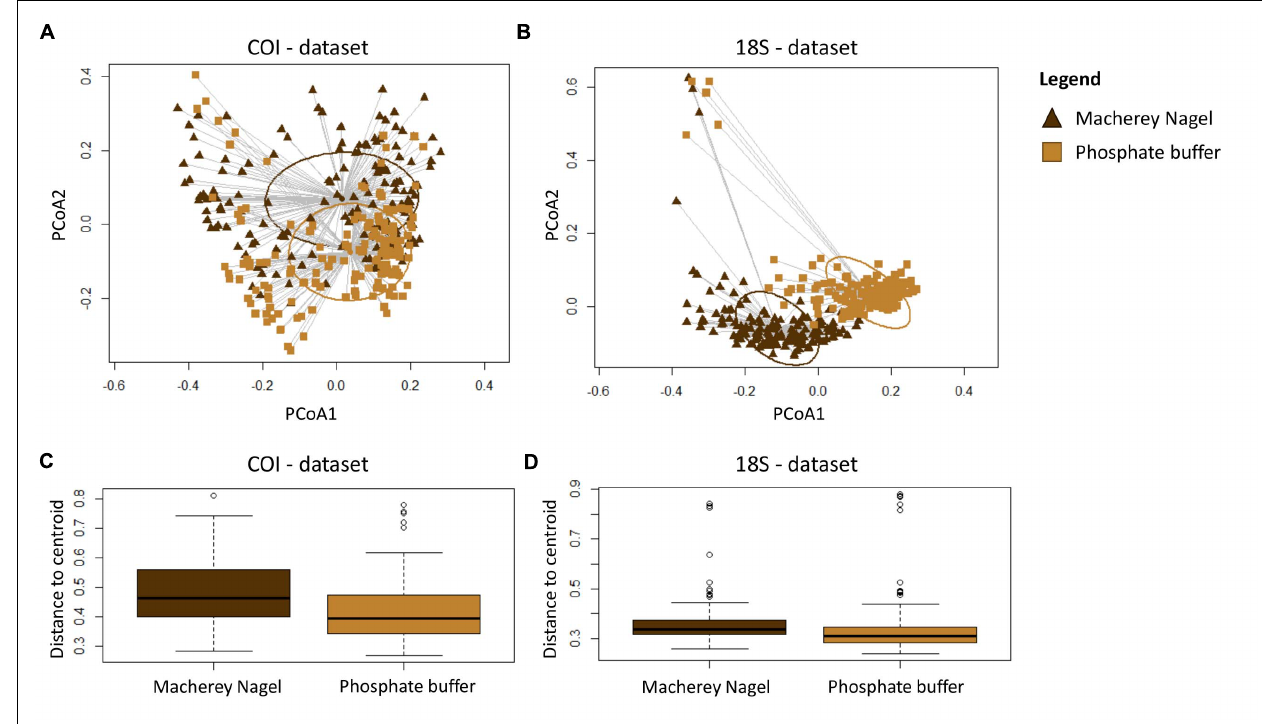
FIGURE 5 | Eukaryotic community composition using Principal Coordinate Analysis (PCoA) based on a “jaccard” dissimilarity index for the (A) COI and (B) 18S dataset for incidence data of detected OTUs with a 90% BlastID to Eukaryota. Group dispersion plots indicate homogeneity of community composition within all soil samples using the same DNA extraction method for the (C) COI dataset and (D) 18S dataset. Light brown indicates community composition assessed using the phosphate buffer; Dark brown indicates community composition assessed with the Macherey Nagel